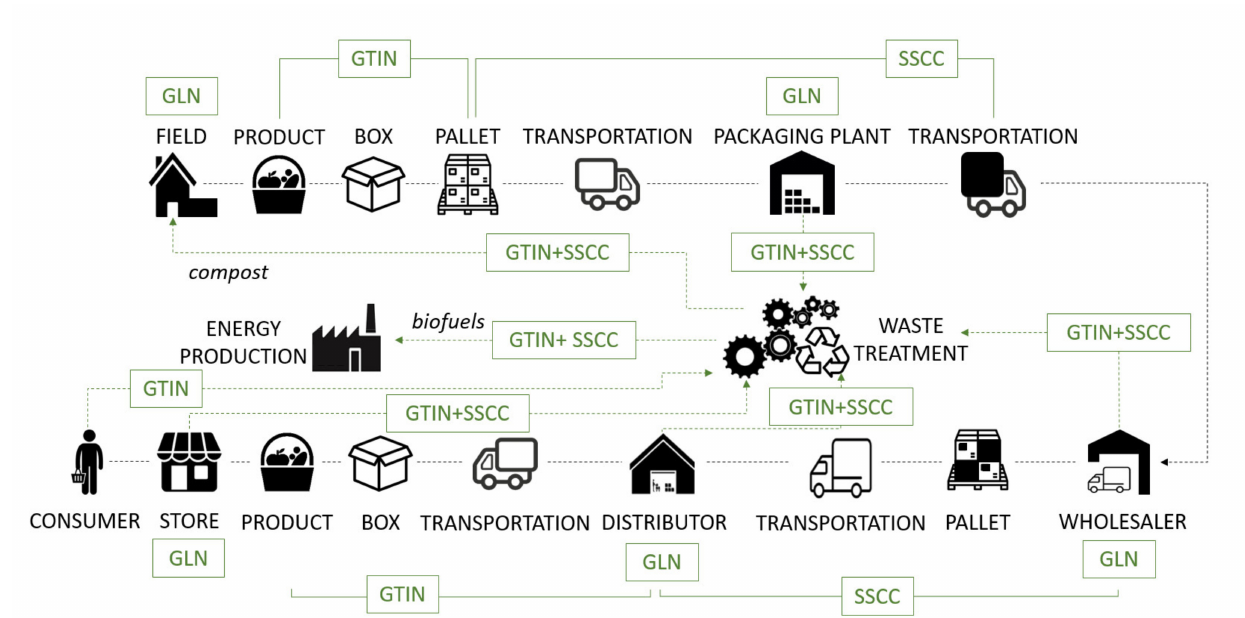
Figure 2. Schematic illustration of the conceptual framework of the AgroTRACE